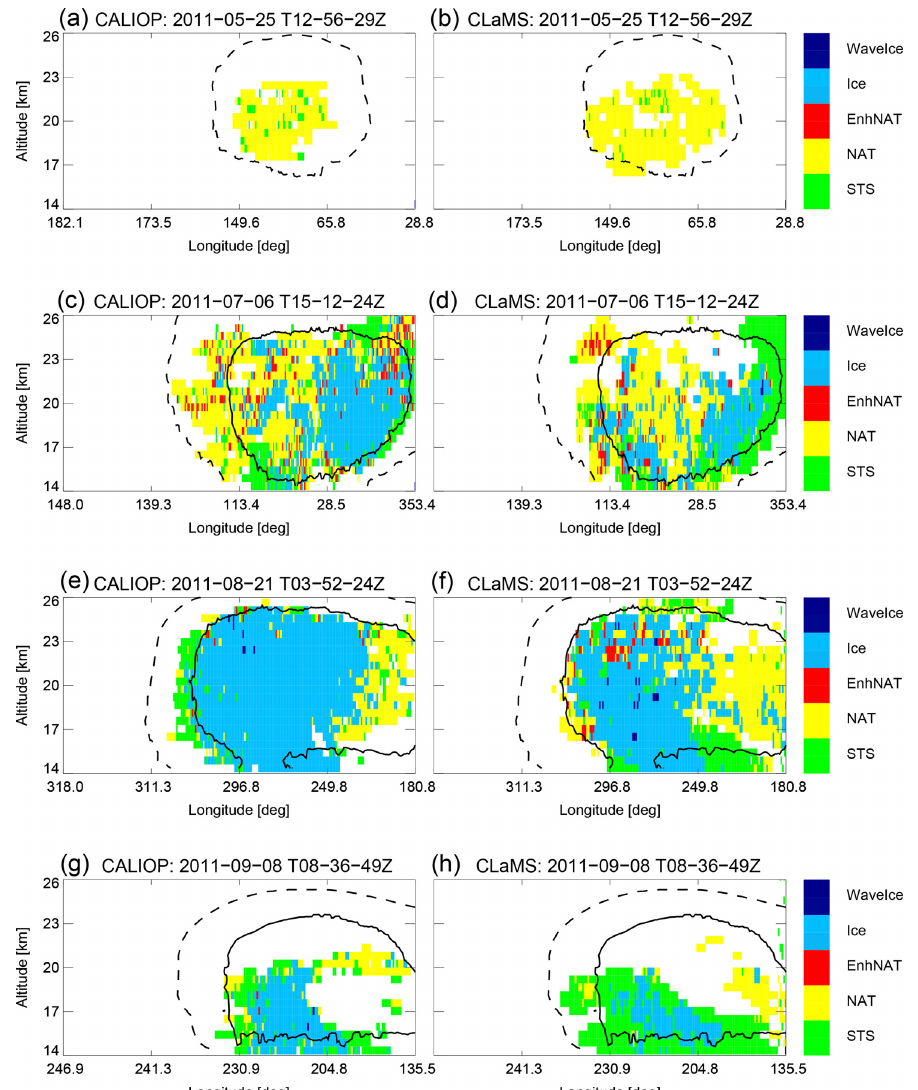
Figure 8. Same as first row in Figs. 3 and 7 but for 4 certain days in SH winter 2011: 25 May (2011-05-25T12-56-29Z, a, b ), 6 July (2011-07-06T15-12-24Z, c, d ), 21 August (2011-08-21T03-52-24Z, e, f ), and 8 September (2011-09-08T08-36-49Z, g, h